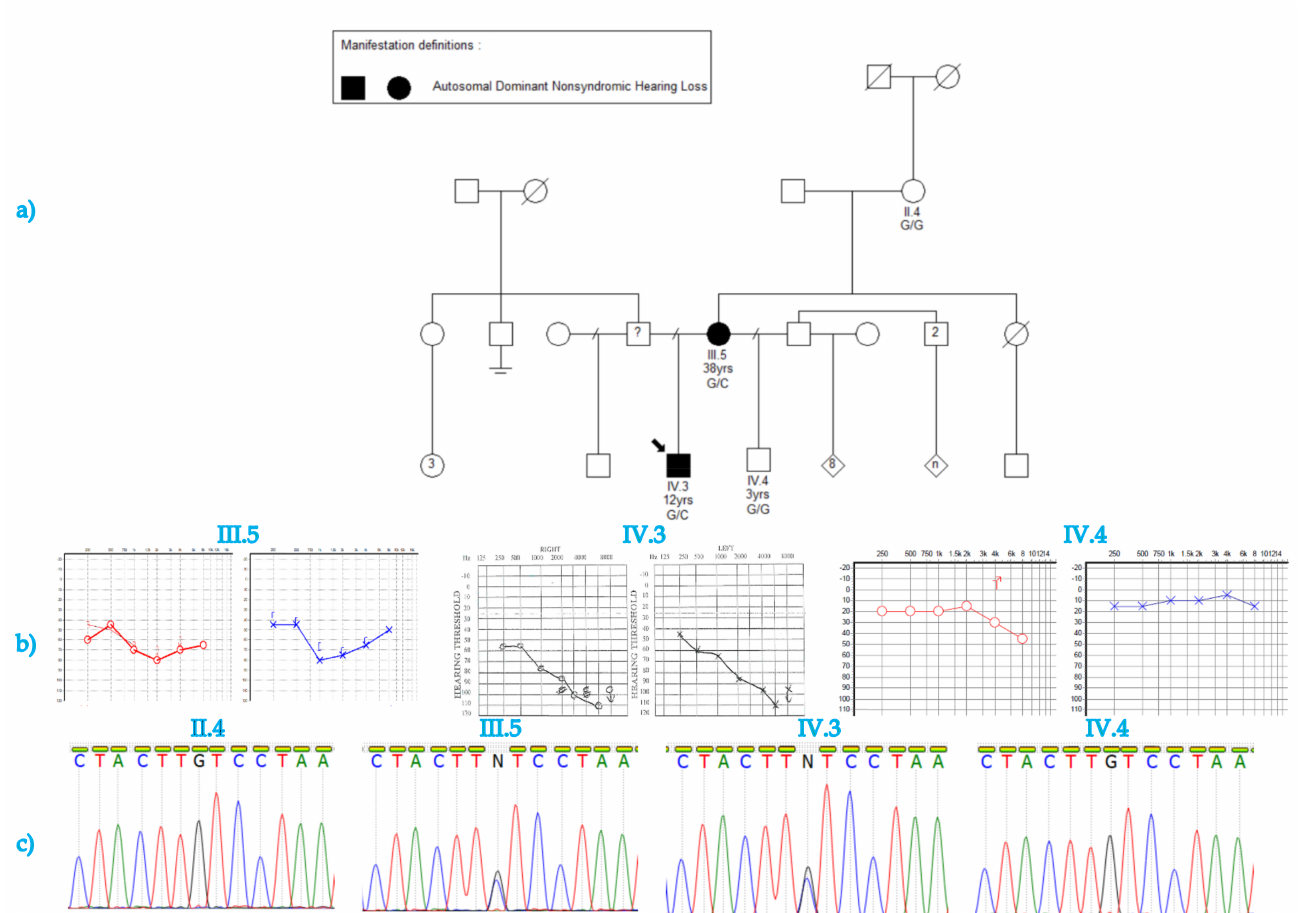
Figure 1. The pedigree of the family presenting with non-syndromic hearing impairment. ( a ) The pedigree suggesting a dominant inheritance model of hearing impairment (HI). The age and genotype are indicated under the ID for the four family members that were available for sequencing. ( b ) audiograms indicate severe hearing impairment in the affected mother and son and normal hearing in the unaffected child. The left ear is blue and the right ear is red in the audiograms for subject III.5 and IV.4. ( c ) The missense mutation segregates within the family with the affected mother and child being heterozygous for the c.1244G>C. The unaffected grandmother and half-brother are homozygous